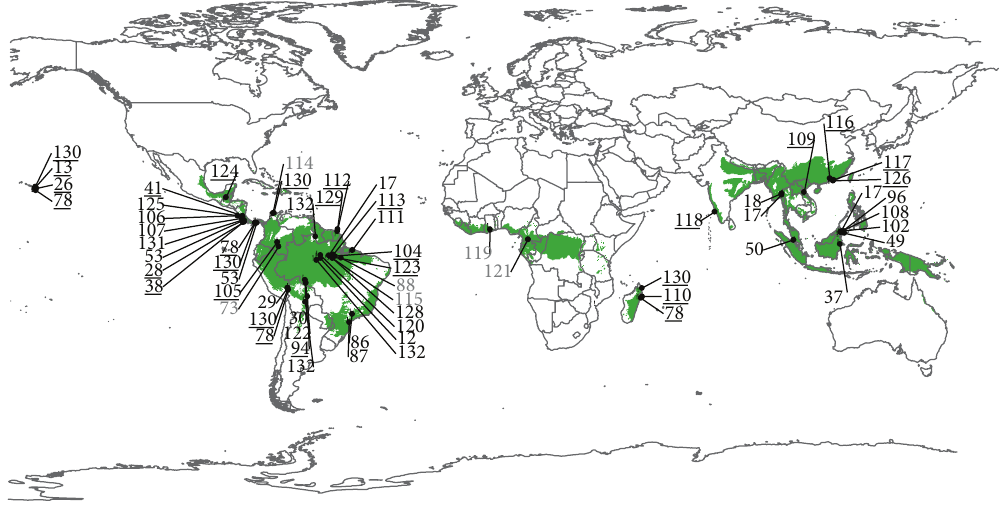
Figure 3: Geographic location of the selected studies. Green area refers to the distribution of the tropical forest biome. Number refers to the article identification on the references (underline black number = spatial resolution ≤ 10m; black numbers = spatial resolution > 10m and ≤ 30 m; grey numbers = spatial resolution > 30